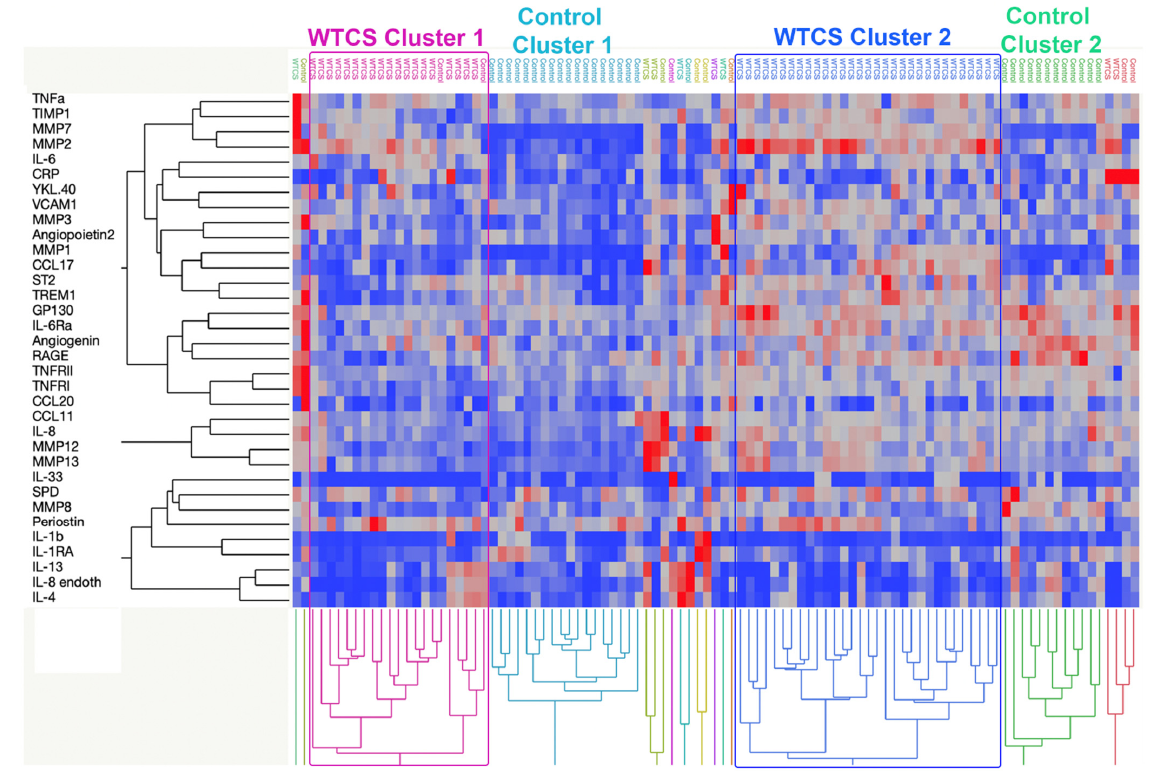
Figure 1 . Hierarchical clustering of WTC survivor (WTCS, n = 58) and NYUBAR control (Control, n = 41) samples by biomarker analytes. Clustering was performed using the method Ward from linear, standardized biomarker data. WTCS clusters 1 and 2, as well as control clusters 1 and 2, are indicated. The colors signify lowest (dark blue) to highest value (bright red). The dendrograms are abbreviated here and shown in full in Supplemental Figures S2 and S3.